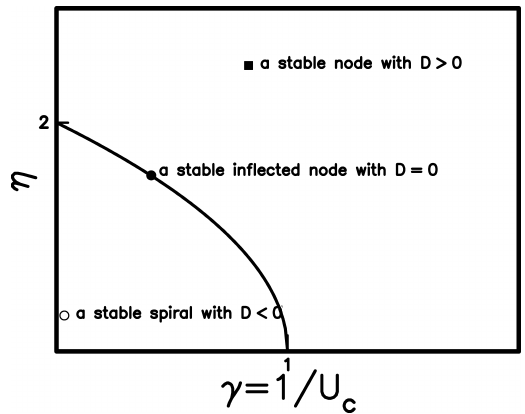
Figure 4. The plot of η versus 1 /U c exhibits the phase portrait and root structure of the system. The solid line displays the function: D(η, 1 /U c ) = η 2 − 4 ( 1 − 1 /U c ) = 0. The solid circle, open circle, and solid square represent, respectively, a stable inflected node with D = 0, a stable spiral with D< 0, and a stable node with D>